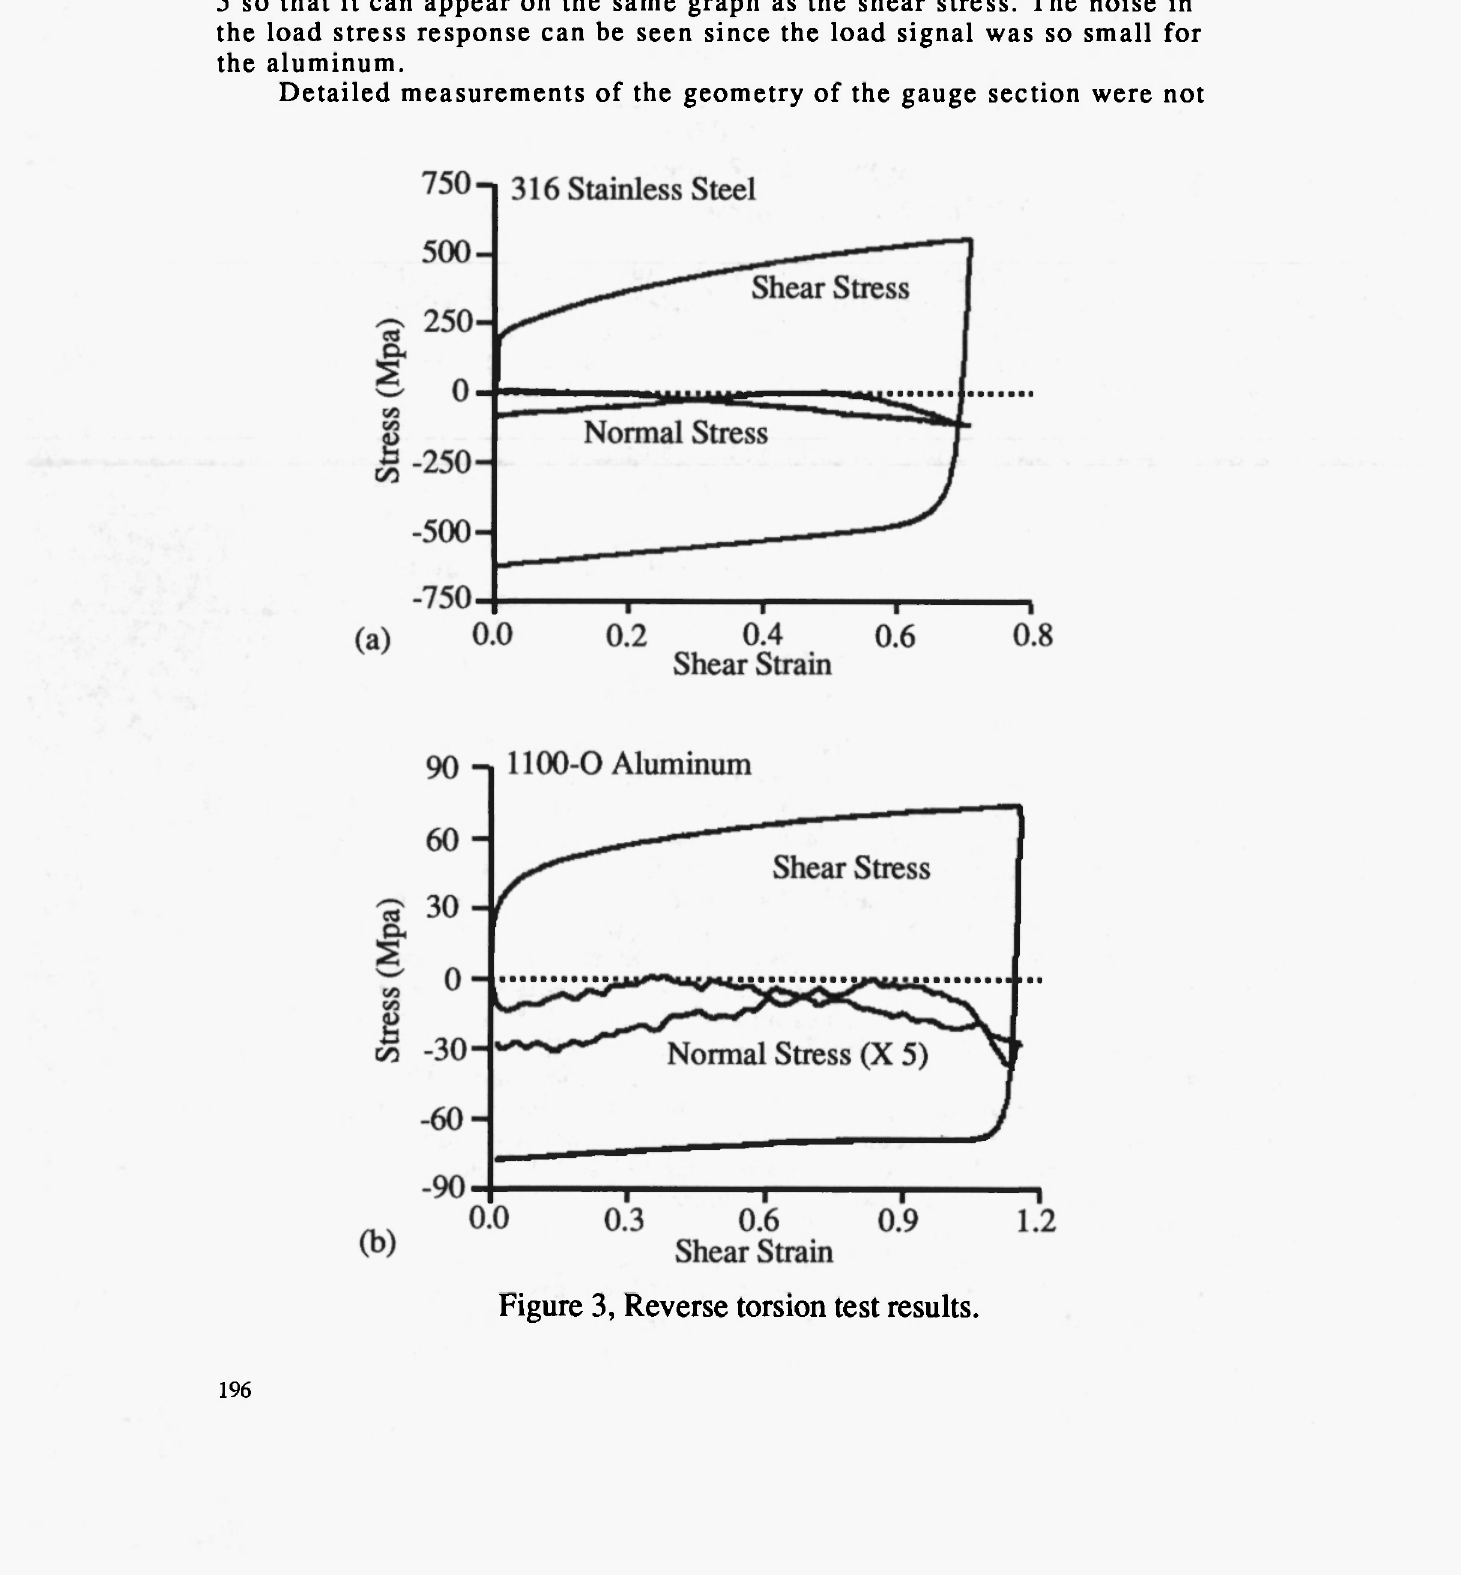
Figure 3, Reverse torsion test